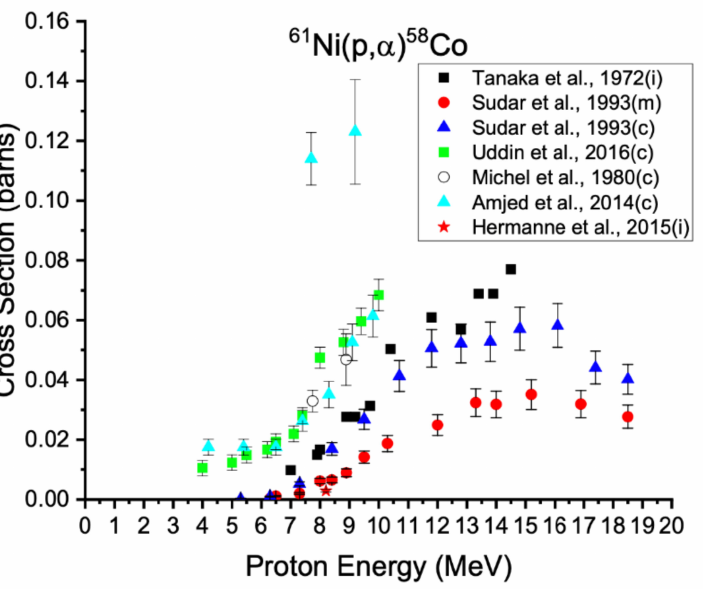
Figure 8. Excitations functions for the production of cobalt-58 on nickel-61 targets [37,66–70]. Data reported by Uddin et al., Michel et al., Amjed et al., and Hermanne et al. are from the irradiation of natural nickel normalized to the abundance of nickel-61, where data beyond the threshold energy for 61 Ni(p,n α ), 10.3 MeV, were not considered.